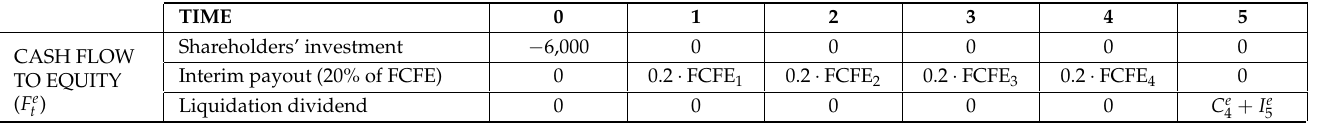
Table A1. Breakdown of CFE (payout ratio: 20% of